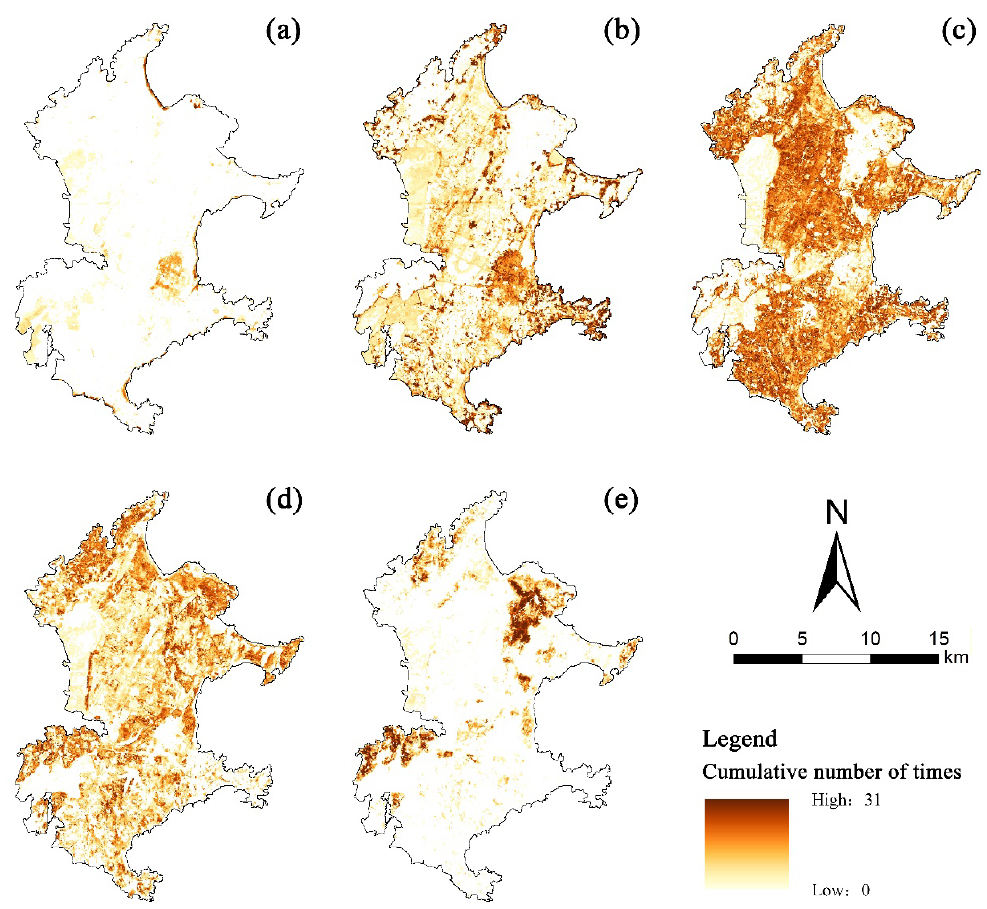
Figure 6. Cumulative number of times for ecological quality (EQ) at different levels over 31 years.